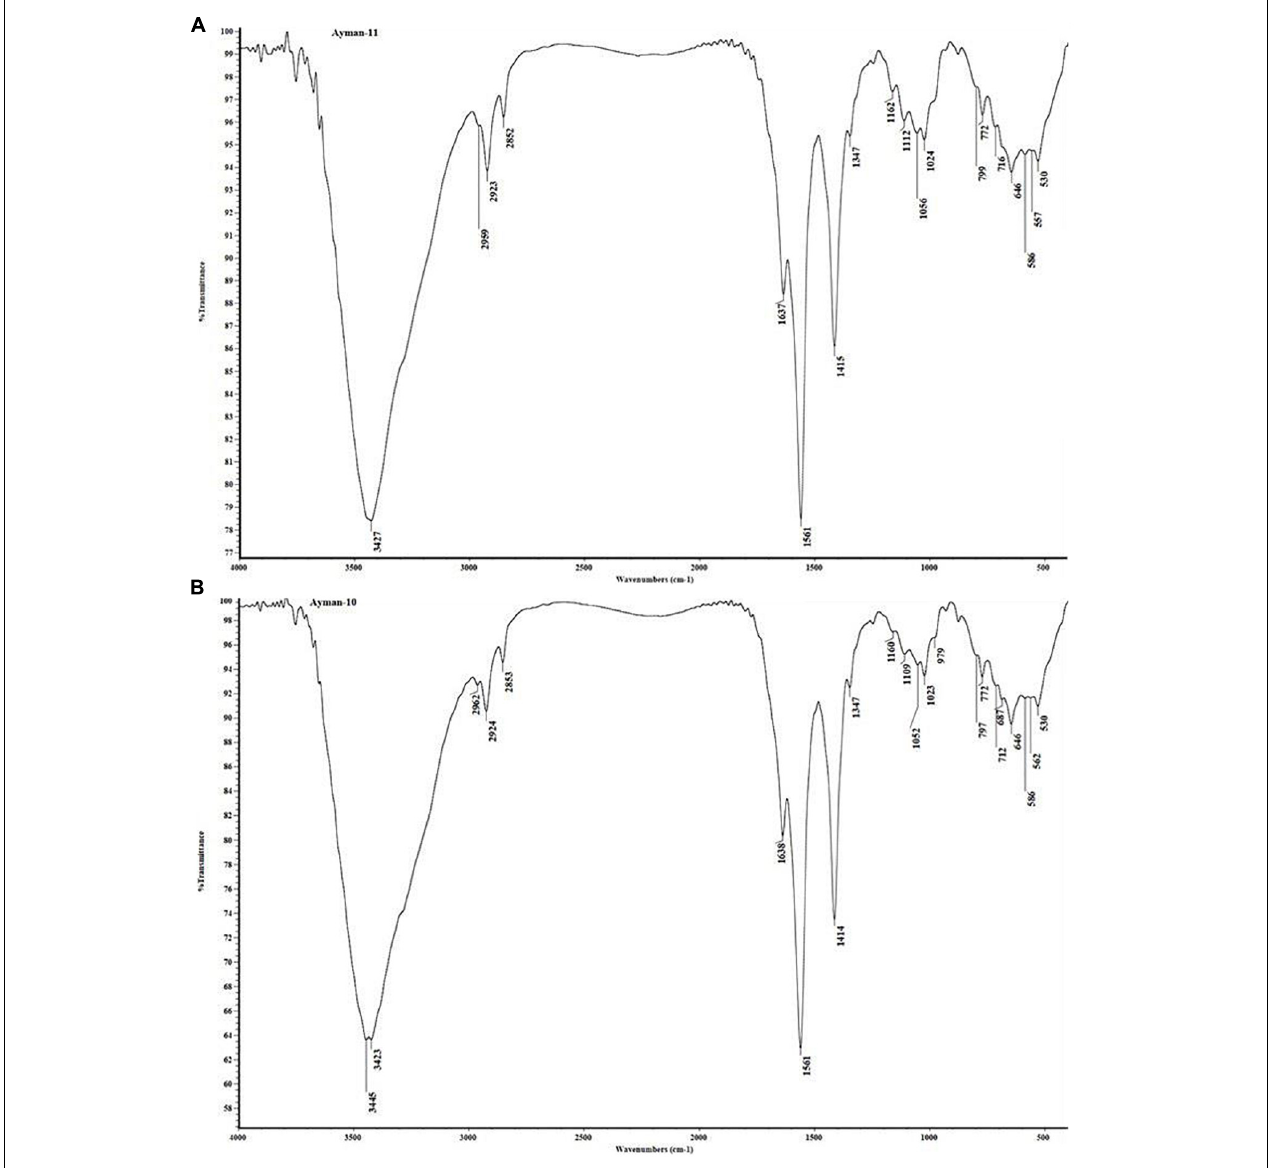
FIGURE 8 | Variation in bands between the untreated (A) and treated (B) cells as a result of Co (II) ions, as detected by the Fourier transform infrared spectroscopy analysis of P . alcaliphila